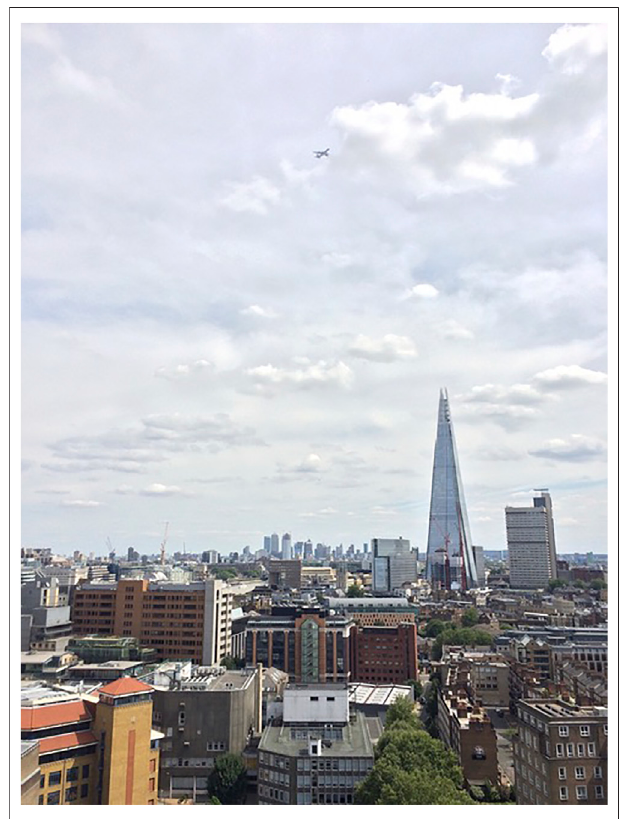
FIGURE 1 | “ View of London city overlooking the Shard and Canary Wharf in the distance. My city that I ’ m falling in love with. ”